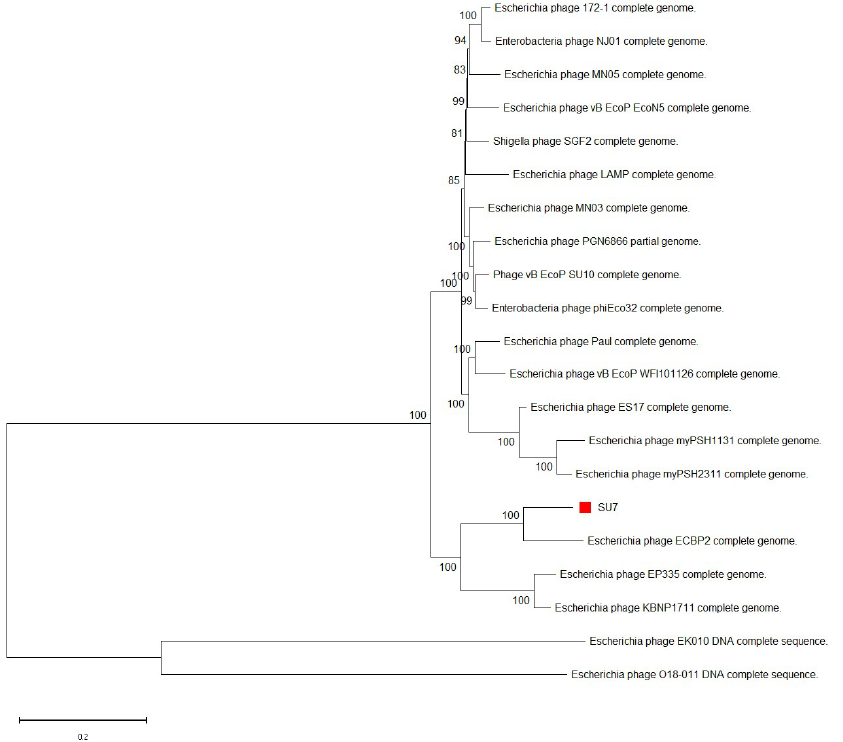
Figure 4. Neighbor-joining phylogenetic tree of phage SU7’s whole genome nucleotide sequence in relation to other Kuraviruses . The sequence of SU7 and genome sequences showing an E-value of 0 in discontinuous MegaBlast searches against the nucleotide collection database at NCBI was aligned in ClustalW. The tree was constructed using Mega-X. The nodes depict the bootstrap values, which were calculated based on 500 replicates. The bar represents the number of nucleotide substitutions per site.